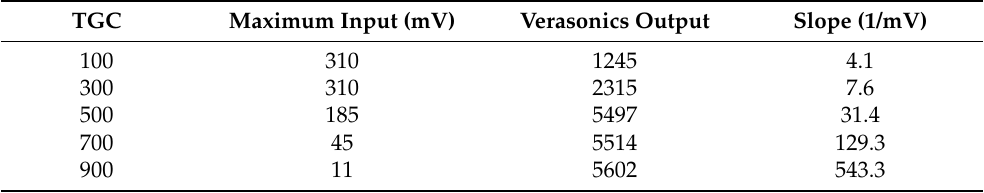
Figure A1. Relation between the input and output of the Verasonics V1 system for several TGC gains at 7.5 MHz. Table A1. Characterization of the Verasonics V1 system for different TGC